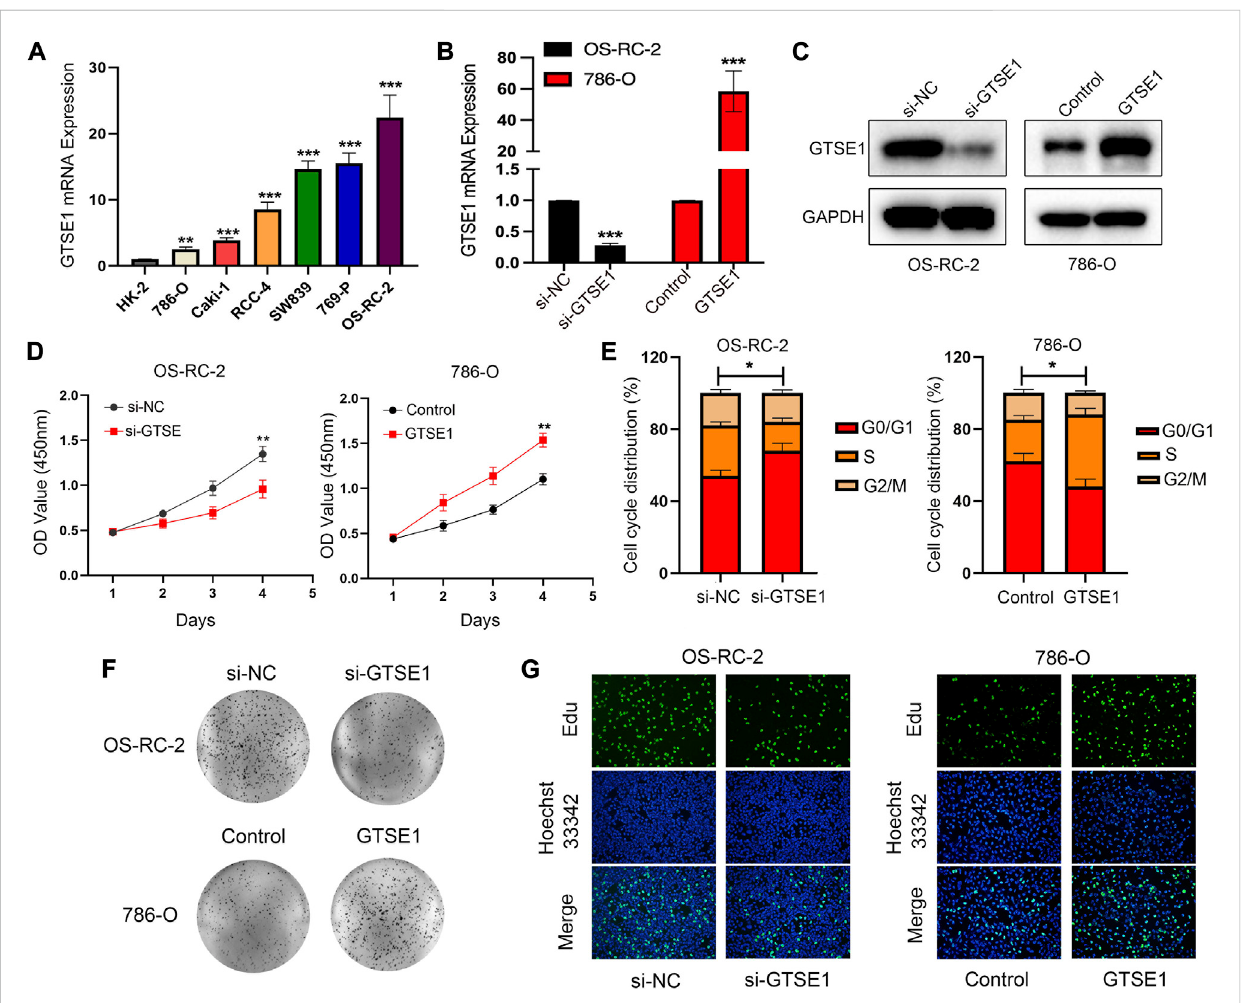
FIGURE 9 Effect of GTSE1 on cell proliferation in ccRCC. (A) qRT ‒ PCR analysis of GTSE1 mRNA expression levels in ccRCC cell lines and the human renal tubular epithelial cell line HK-2. The ef fi ciency of GTSE1 knockdown or GTSE1 overexpression was measured by qRT ‒ PCR (B) and Western blotting (C) analysisinOS-RC-2or786-Ocelllines. (D) CellviabilityofccRCCcellswasassessedbyMTTassay. (E) CellcycledistributionofccRCCcellswasdetected by cell fl ow cytometry (FCM) analysis. The results are shown as a histogram of the mean ± SD of three independent experiments. (F) A colony- formationassaywasconductedinccRCCcells. (G) DNAreplicationactivitywasassessedbyanEdU-stainingassay(greenindicatestheEdU-incorporated cells; blue indicates nuclei). GAPDH was used as an internal control. * p < 0.05, ** p < 0.01, *** p <